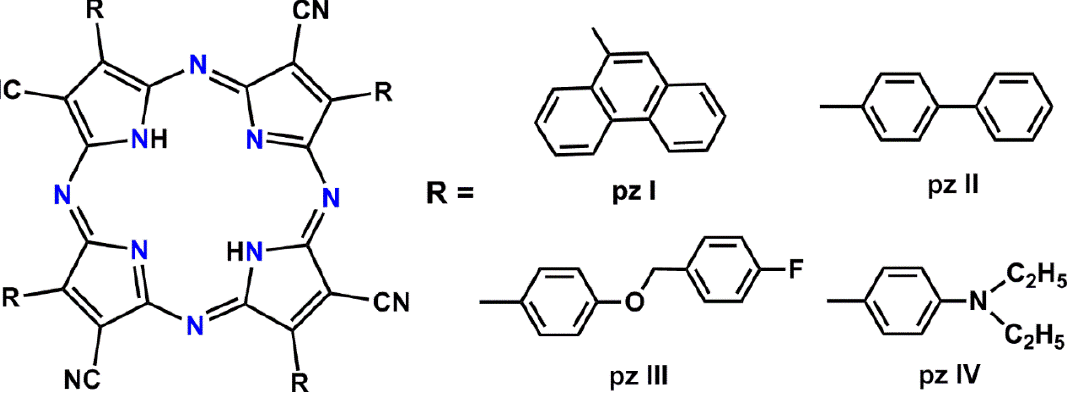
Figure 1. A chemical structure of the synthesized tetracyanotetra(aryl)porphyrazines: pz I , pz II , pz III , and pz IV .